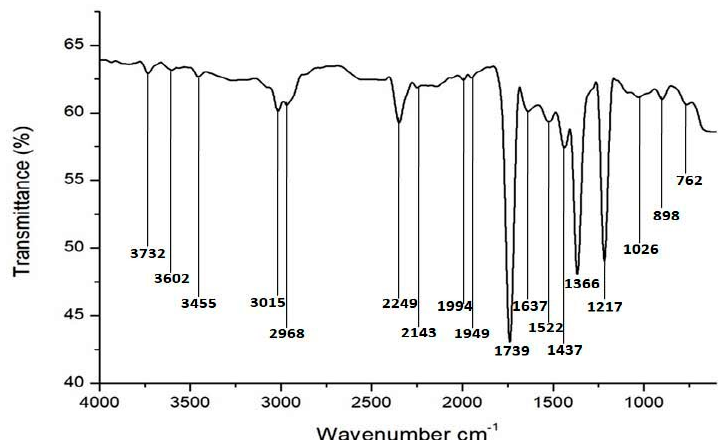
Figure 6. Fourier transform infrared spectroscopy (FTIR) spectrum of biosynthesized AgNPs using Citrobacter spp. MS5 culture supernatant as a reducing and stabilizing agent.